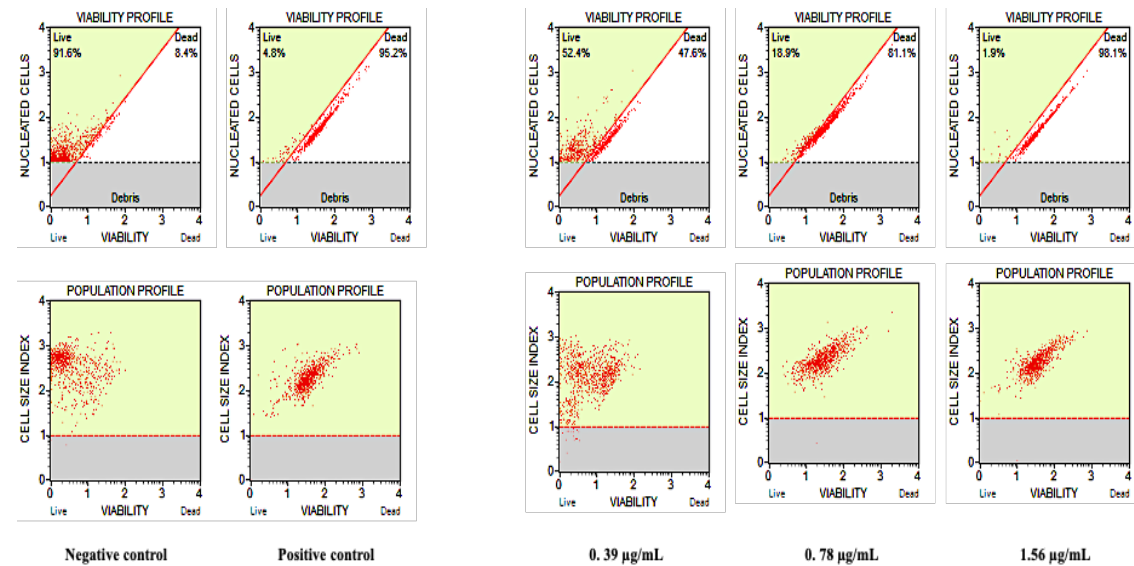
Figure 5. Effect of Ag-Cu-Co Trimetallic nanoparticles on cell count and viability of C. auris MRL 6057. The figure demonstrates the viability and population profile of C. auris MRL 6057. Healthy growing C. auris represented as negative control; cells treated with 10 mM H 2 O 2 as a positive control; C. auris exposed to Ag-Cu-Co trimetallic nanoparticle at different MIC values (0.39 µg/mL, ½ MIC; 0.78 µg/mL, MIC; 1.56 µg/mL, MFC).